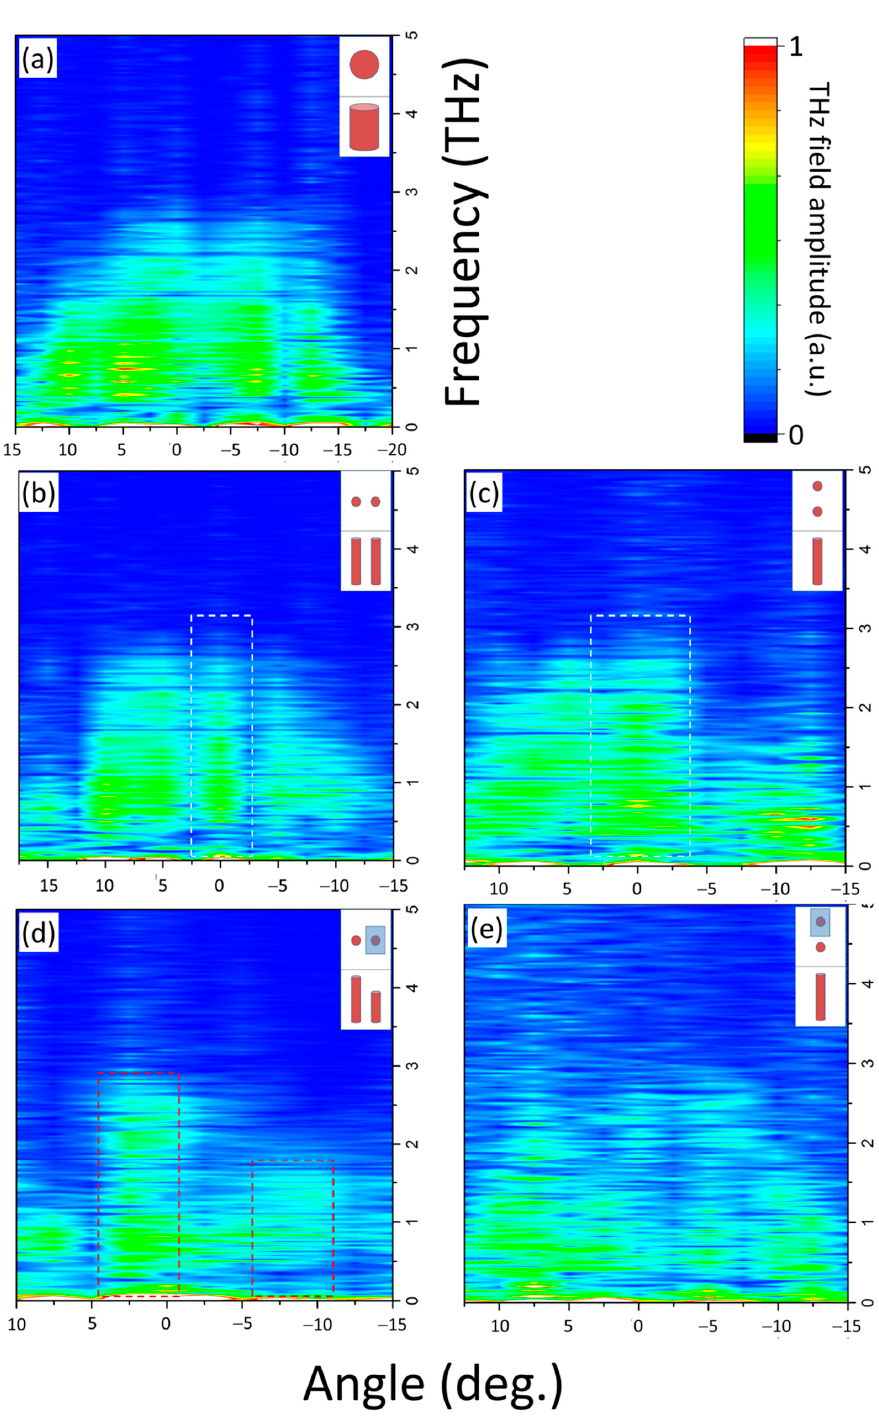
Figure 4. Frequency-angular distributions of THz emission. ( a ) free beam without a mask; ( b , c ) Two beamlets regularized forming superfilament-like structure; ( d , e ) Two independent delayed filaments. Measurements ( b , d ) were made with horizontal orientation of mask holes and ( c , e ) with vertical one. White rectangles in ( b , c ) highlight the component of THz radiation that propagates along the axis of the laser beam, red rectangles in ( d ) highlight the feature of THz emission from two delayed beamlets.